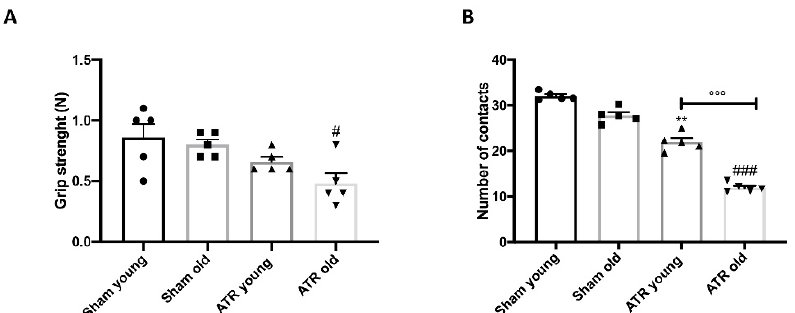
Figure 4. Effect of ATR inhalation on grip strength and sociability. Grip strength ( A ); Social interaction test ( B ). Aged mice were more susceptibility to develop a reduction in grip strength and social interaction compared to young mice after ATR inhalation. Data is expressed as the mean ± SEM of n = 5 animals for each group. * p < 0.05 vs. Sham young; ** p < 0.01 vs. Sham young; # p < 0.05 vs. Sham old; ### p < 0.001 vs. Sham old; °°° p < 0.001 ATR old vs. ATR young.